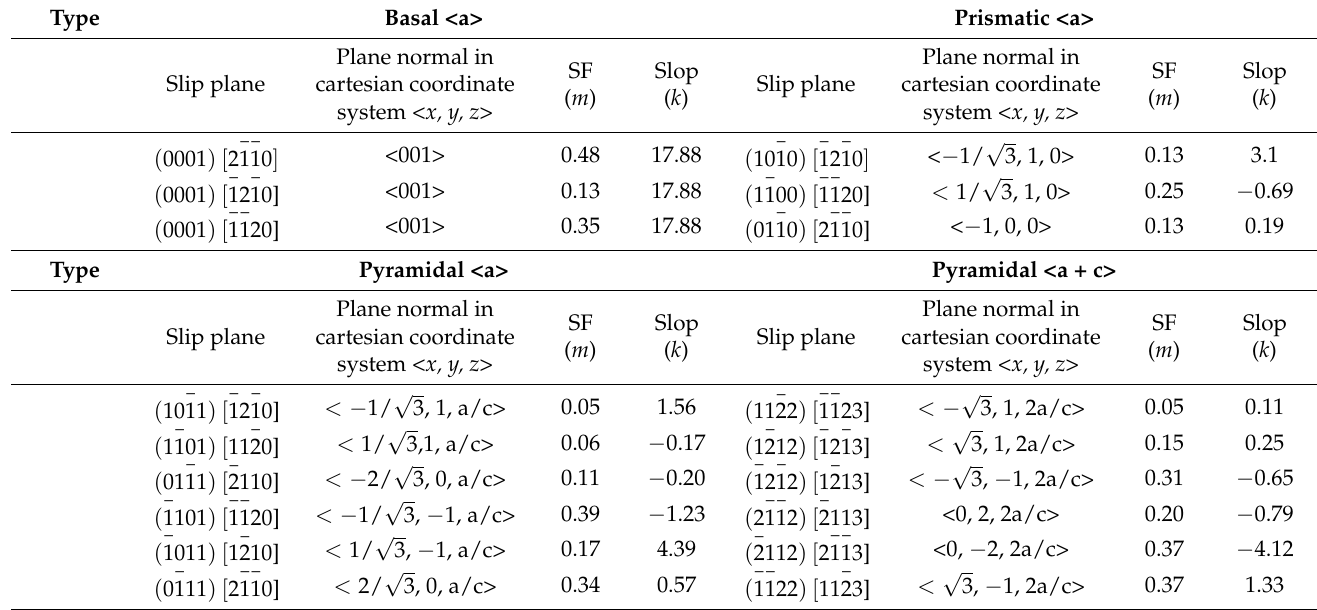
Table 1. All the possible normal directions of slip planes were calculated using Equation (1). The slip trace slops ( k ) and SFs ( m ) with an orientation (356.8 ◦ , 135.2 ◦ , 250.5 ◦ ) were calculated in this